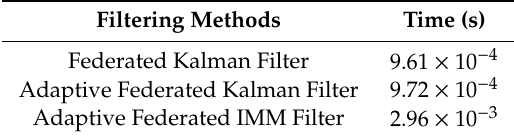
Table 3. The implementation times of the three filtering methods in single step run.